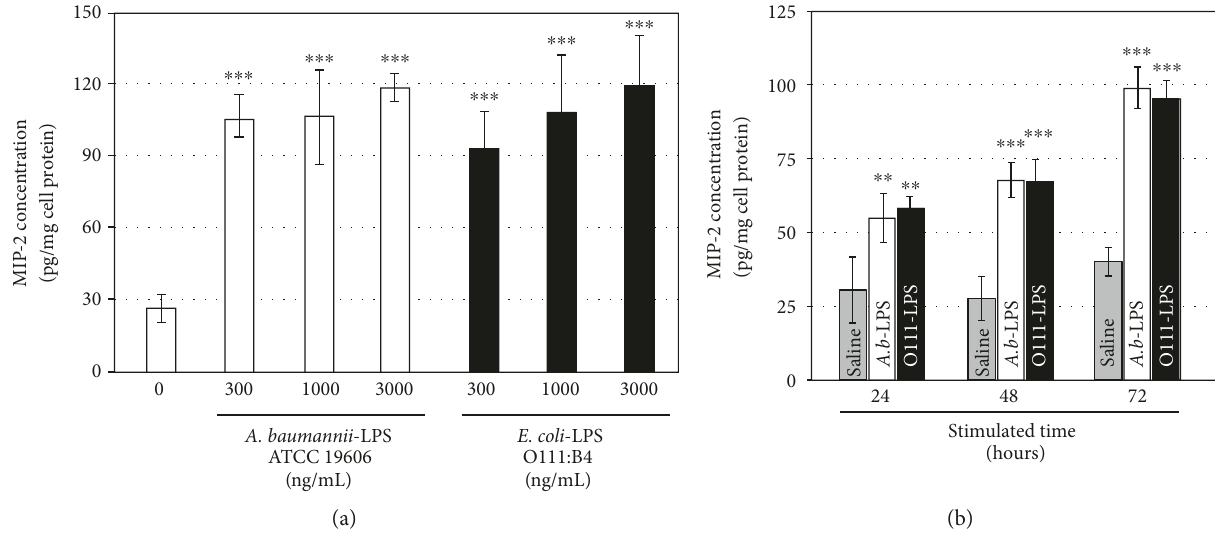
Figure 4: E ff ect of A. baumannii -LPS on MIP-2 secretion from 3T3-L1 adipocytes. (a) The dose-dependent e ff ect of A. baumannii -LPS on MIP-2 secretion from adipocytes. The 3T3-L1 cells were seeded at a density of 4 × 10 5 cells/well in 35mm dishes, and the cells were di ff erentiated into adipocytes in MIX-Di ff medium. The adipocytes were then incubated for 72h in fresh medium containing 300, 1000, and 3000ng/mL of A. baumannii -LPS (ATCC 19606) or E. coli -LPS (O111:B4) and measured for the level of MIP-2 protein in the culture medium by ELISA. (b) MIP-2 secretion from adipocytes was measured at the indicated time points following treatment with 1000 ng/mL A. baumannii -LPS (ATCC 19606), 1000ng/mL E. coli -LPS (O111:B4), or saline. All experiments were performed in triplicates, and the results are shown as the mean ± SD. ∗∗ P < 0 01 (compared to cells without LPS treatment). ∗∗ P < 0 01 ; ∗∗∗ P < 0 005 (compared to adipocytes without LPS treatment).